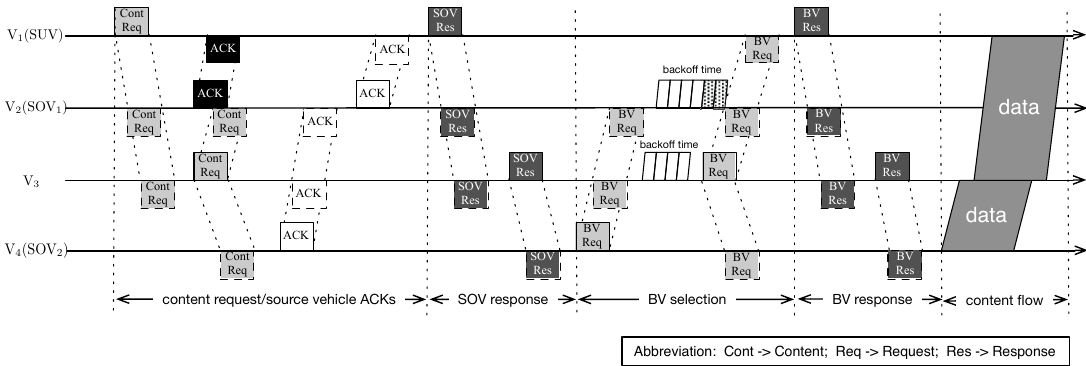
Figure 2. A sketch map for illustrating the designed routing protocol.